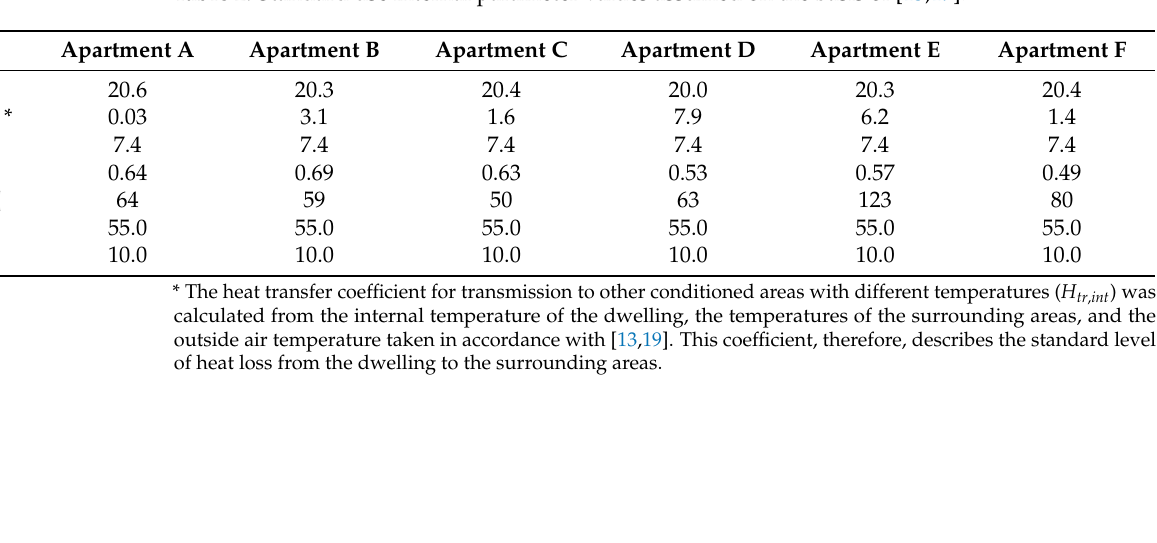
Table 2. Standard use internal parameter values assumed on the basis of